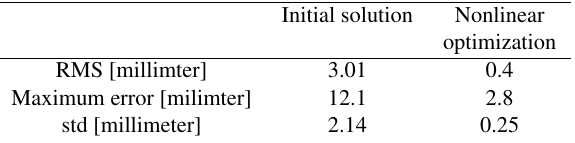
Table 2: The point-based back-projection error (19) from the ex- periment with Ladybug 3 camera.